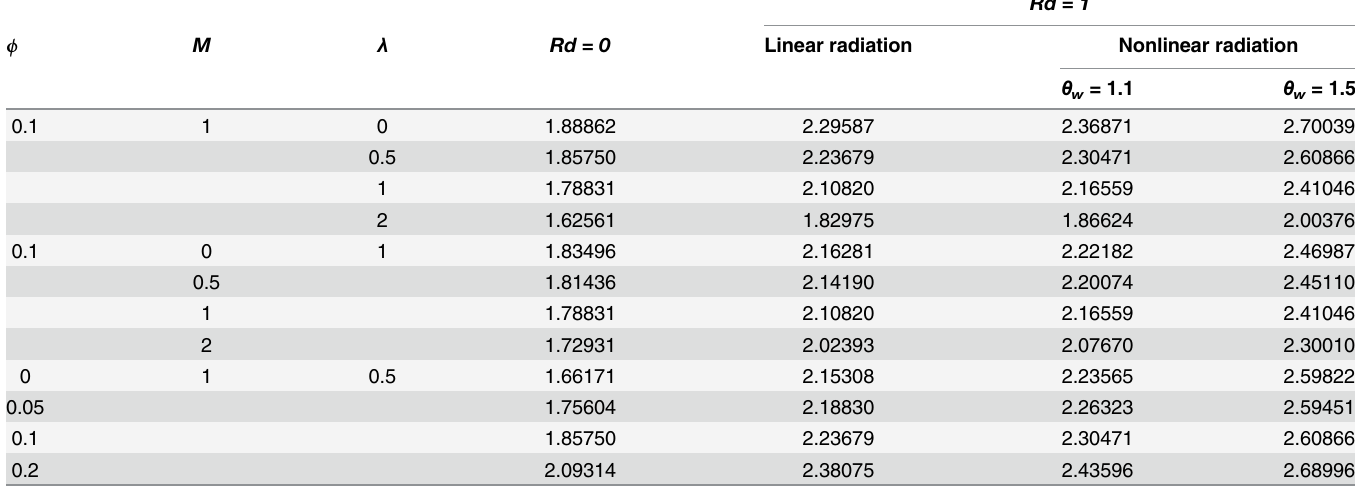
computed in Table 4. The magnitude of Nu when larger wall to ambient temperature ratio is accounted. Moreover Nu well as non-linearly relationship with the radiation parameter Rd . This outcome is true for both linear and non-linear radiation cases. Figs 2 and 3 preserve the effects of magnetic field strength on the dimensionless x − and y − components of velocity respectively. The function g ( η ) has a parabolic profile and its value is negative revealing that flow occurs in the negative y − direction. As the Hartman number M enlarges, the flow decelerates in both x − and y − directions. Physically, the presence of magnetic field restricts the fluid motion due to which a thinner boundary layer appears for stronger mag- netic field strength. p ffiffiffiffiffiffiffiffi Re x for different values of embedded